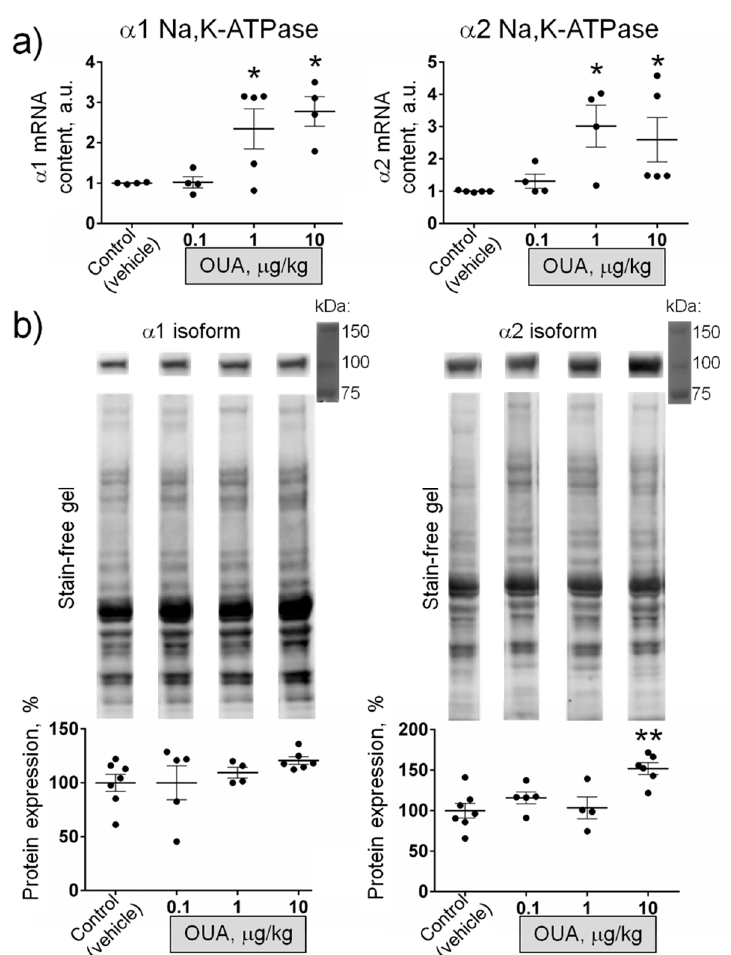
Figure 6. Chronic exposure to ouabain (OUA) specifically alters mRNA level and protein content of the α 2 Na,K-ATPase in whole homogenate of diaphragm muscles. Rats were injected for 4 days with different doses (µg/kg) of ouabain as indicated. ( a ) Relative mRNA level for the α 1 and α 2 isoforms ( n = 4–5). ( b ) Averaged Western blot analyses of α 1 and α 2 isoform protein expression ( n = 4–7); representative Western blots for semi-quantification of the Na,K-ATPase α 1 and α 2 isoforms are shown. * p < 0.05 and ** p < 0.01 compared with the control (vehicle treated group).